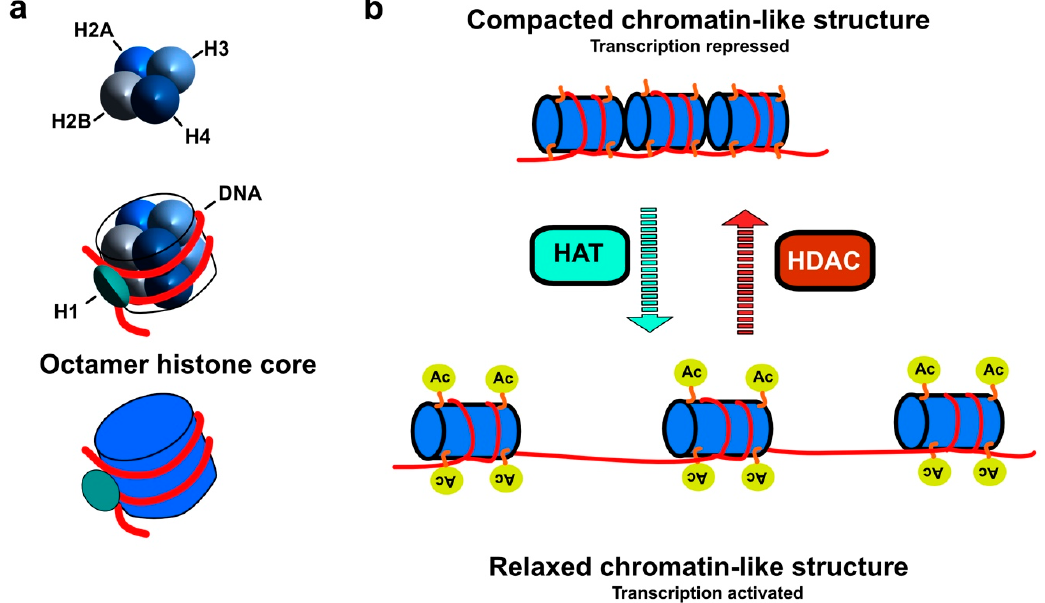
Figure 1. Illustration of histone core composition and impact of chromatin relaxation or compaction by histone acetyltransferases (HAT) or histone deacetylases (HDAC) on gene expression ( a ) Histone protein consists of five main types H1, H2A, H2B, H3, and H4. Two copies of each histone type (2H2A, 2H2B, 2H3, and 2H4) constitute the octamer histone core (nucleosome), wrapped by approx. 146 bp of DNA. H1 is known as linker histone that is associated to linker DNA between each nucleosome. ( b ) Epigenetic modification of histone proteins by HDAC/HAT. HAT stimulates transcriptional